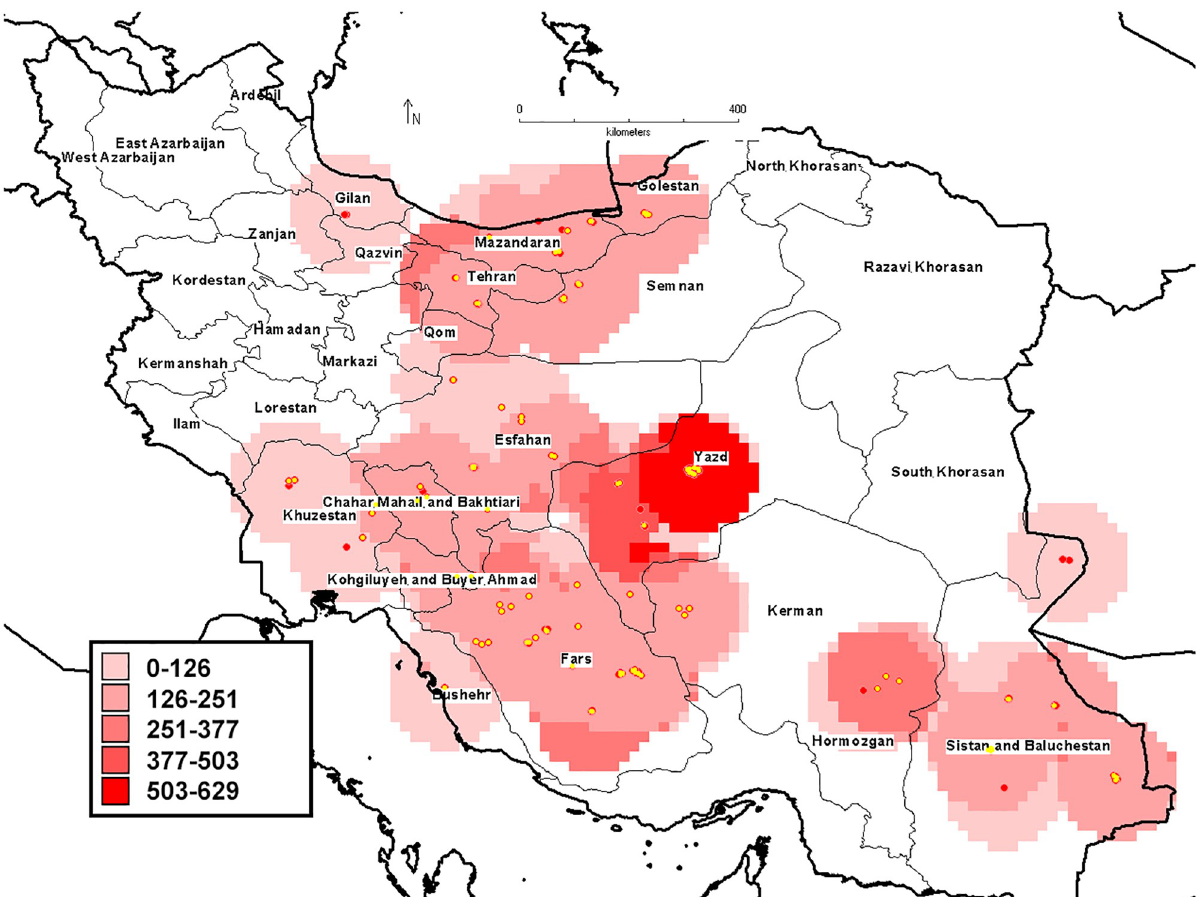
Fig 3. Distribution map of 152 pomegranate genotypes based on biochemical properties (CV).